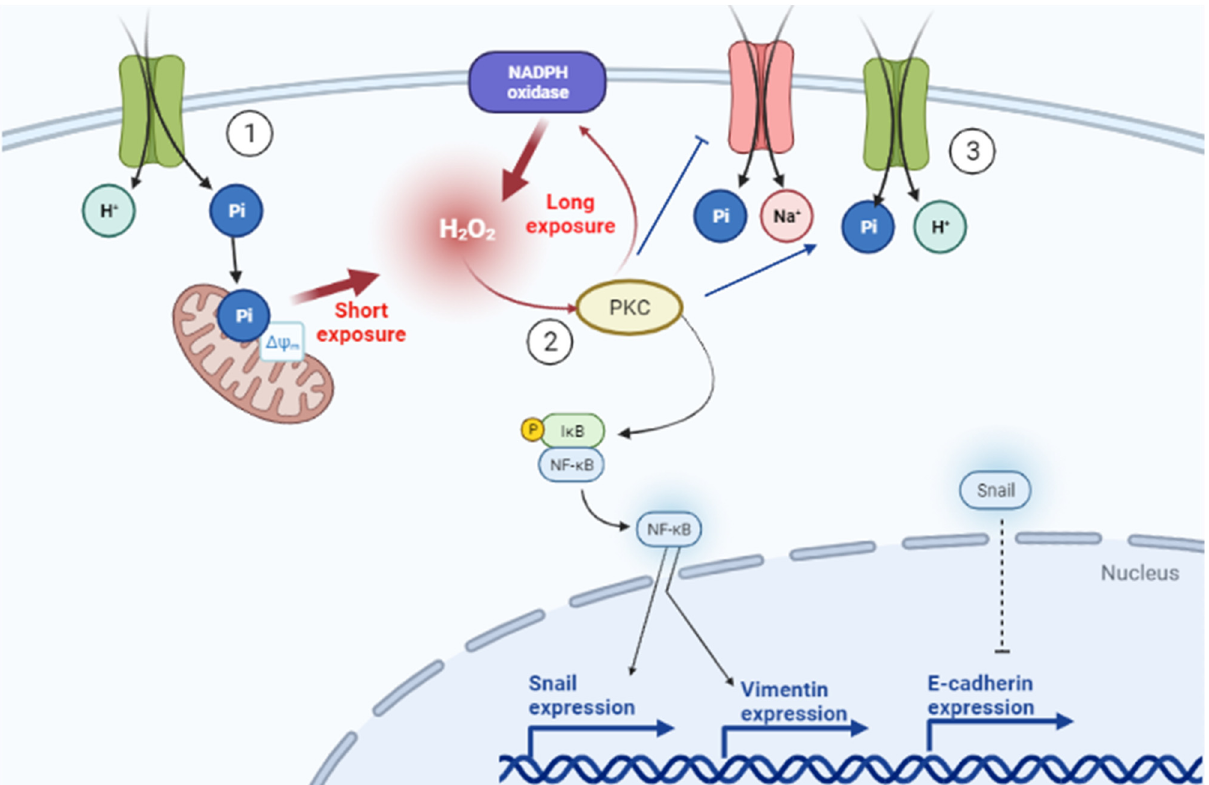
Figure 13. Schematic representation of Pi-induced peroxide hydrogen production and its role in Pi transporters modulation in MDA-MB-231 cells. ( 1 ) An increase in intracellular Pi occurs through specific Pi transport sensitive to PAA. In a short Pi exposure, Pi hyperpolarizes the mitochondrial membrane and increases the release of mitochondrial H 2 O 2 sensitive to FCCP and mitoTEMPO. In long Pi exposure, nicotinamide adenine dinucleotide phosphate (NADPH) oxidase (NOX), sensitive to VAS2870, is the secondary source of H 2 O 2 production. ( 2 ) Increase of intracellular H 2 O 2 activates PKC, which possibly phosphorylate and activate IKK, a kinase of IkB, the inhibitor that hijacks the transcription factor NF-kB in cytoplasm, which once phosphorylated releases NF-kB to enter in the nucleus to start the transcription of genes related to Snail (an E-cadherin repressor expression), vimentin and E-cadherin. Moreover, ( 3 ) PKC activated by H 2 O 2 inhibits Na + -dependent Pi transporter, stimulates H + -dependent Pi transporter, and therefore, stimulates migration and cell adhesion to ECM. Figure created with BioRender.com.